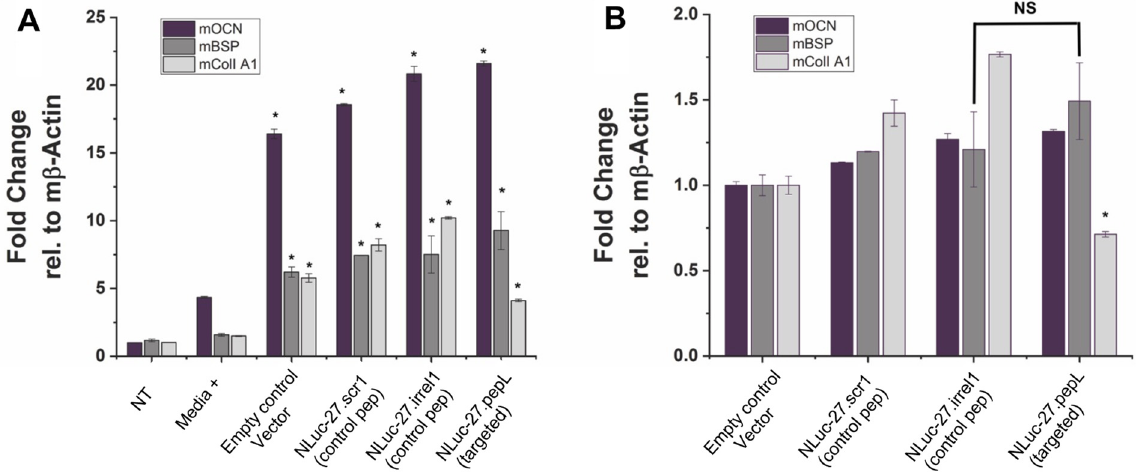
Figure 10. Targeted Nluc-27 upregulates genes associated with osteoblast differentiation in the mouse MC3T3-E1 (Subclone 14) pre-osteoblastic cell line. ( A ) Relative to no treatment (set at 1.0) and positive control (media+; containing differentiation supplements), all CM induced higher levels of the three osteoblast-differentiation genes assayed (*, p < 0.05). Shown are fold changes in gene expression by qPCR relative to mouse β -actin. ( B ) Relative to control empty vector CM (set at 1.0), moderate upregulation of osteoblastic-differentiation genes was detected in response to NLuc-27.scr1 or irrel1, but this difference was not significant (ns). Shown are fold changes in gene expression by qPCR relative to mouse β -actin. Changes in mBSP trended higher for Nluc-27.pepL relative to control and Nluc-27.irrel1, but the only significant change for Nluc-27.pepL was a reduction in the levels of Col IA1 relative to the control Nluc-27s (scr1, and irrel1)(*, p < 0.05). All gene-expression analyses were from MC3T3-E1-14 cells isolated at day 7 of treatment. Data are presented as mean ± SEM. Comparisons were performed using one-way